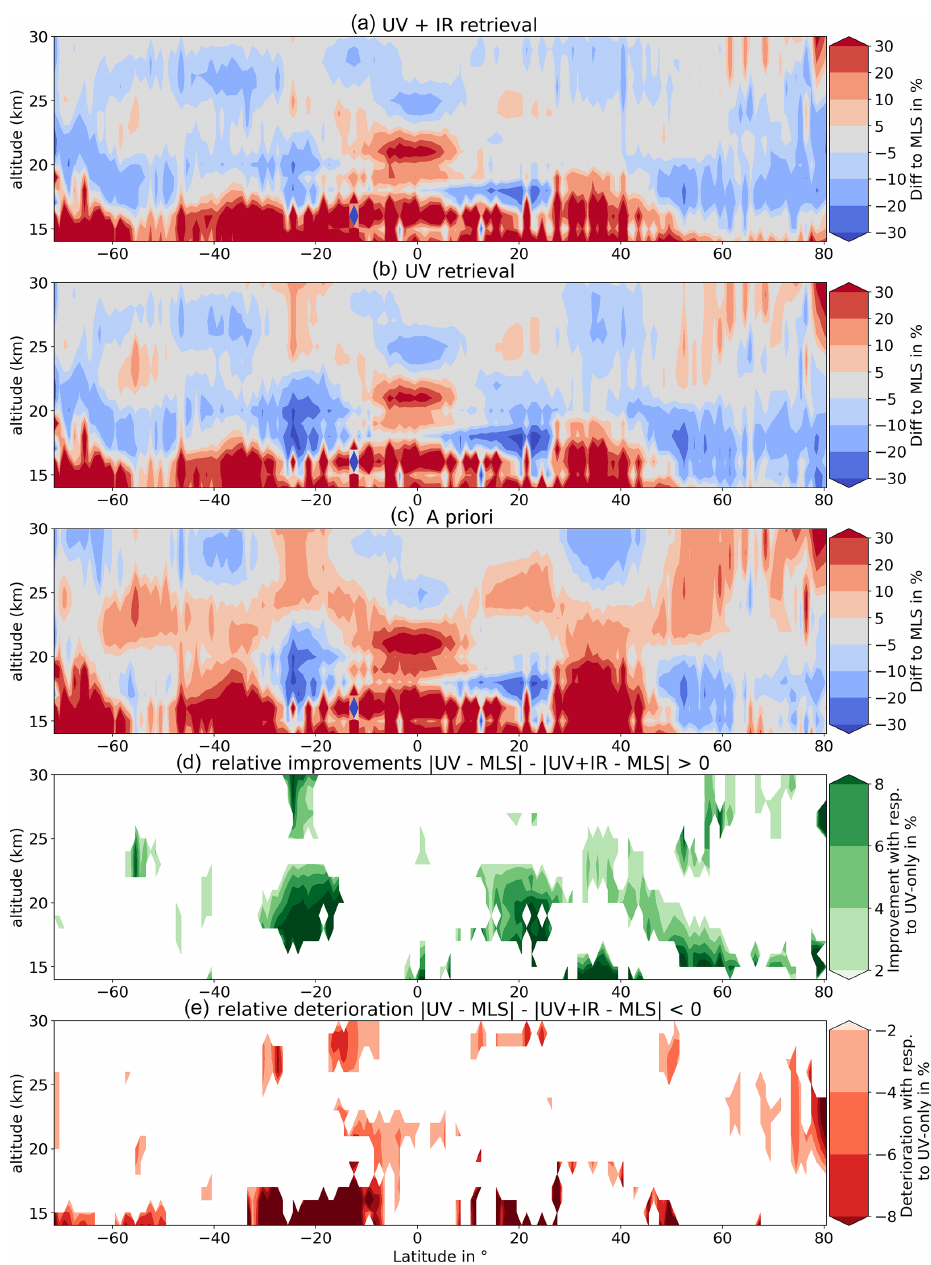
Figure 13. Zonal mean differences in percent between combined TOPAS ozone profiles (a) , UV-only TOPAS profiles, (b) as well as the climatological (a priori) (c) and MLS data on 1 October 2018. Panels (d) and (e) show the difference between the relative differences from panels (a) and (b) , which can be interpreted as improvement/deterioration in the UV + IR retrieval with respect to the UV-only retrieval. All changes within ± 2% are masked out to highlight the larger